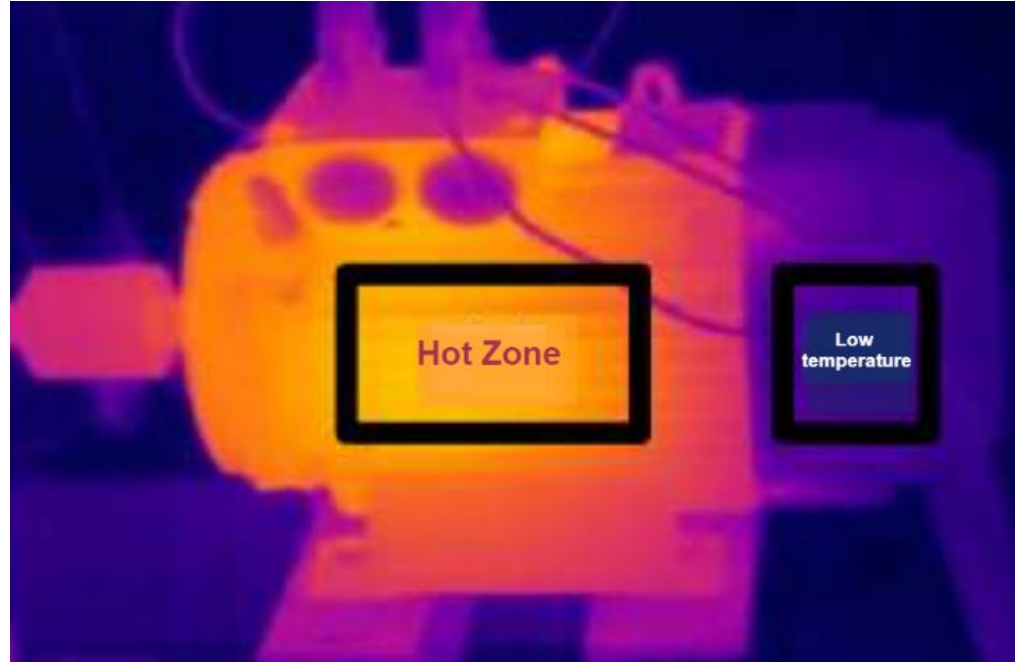
Figure 5. Infrared image of a healthy IM with no load [35].